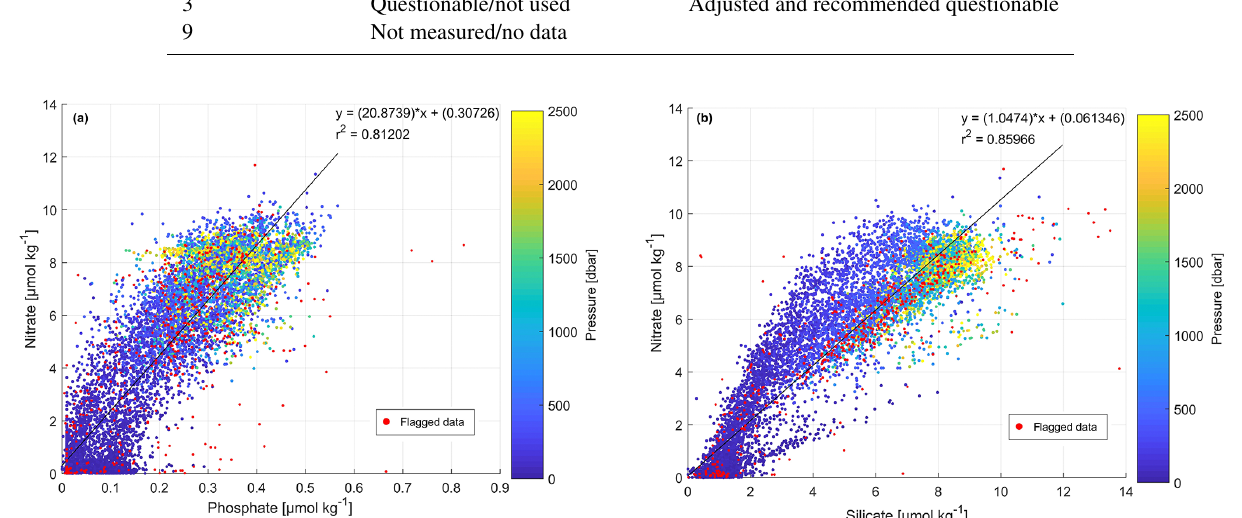
Figure 3. Scatter plots of (a) phosphate vs. nitrate (µmolkg − 1 ) and (b) silicate vs. nitrate (µmolkg − 1 ). Data that have been flagged as questionable (flag 3) are in red; the colour bar indicates the pressure (dbar). The black lines represent the best linear fit between the two parameters, and the corresponding equations and r 2 values are shown in each plot. Average resulting N : P ratio is 20.87; average resulting N : Si ratio is 1.05 (whole